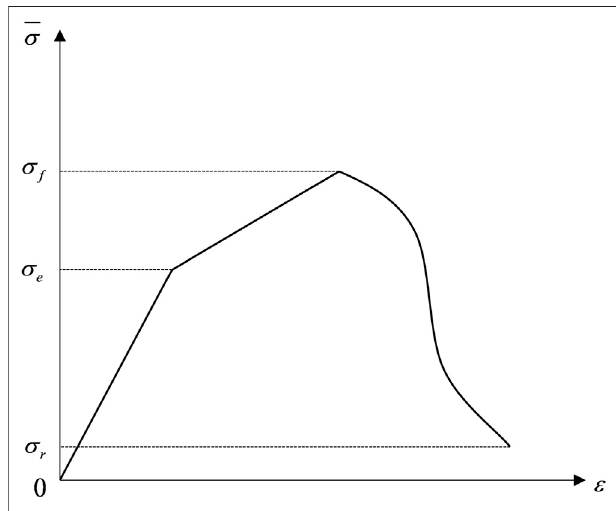
FIGURE 6 | RHT constitutive model.